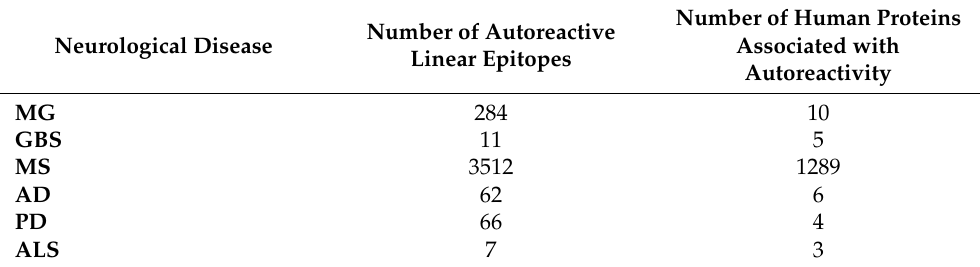
Table 3. Number of linear autoreactive epitopes collected for the 6 neurological diseases and the number of human proteins that they